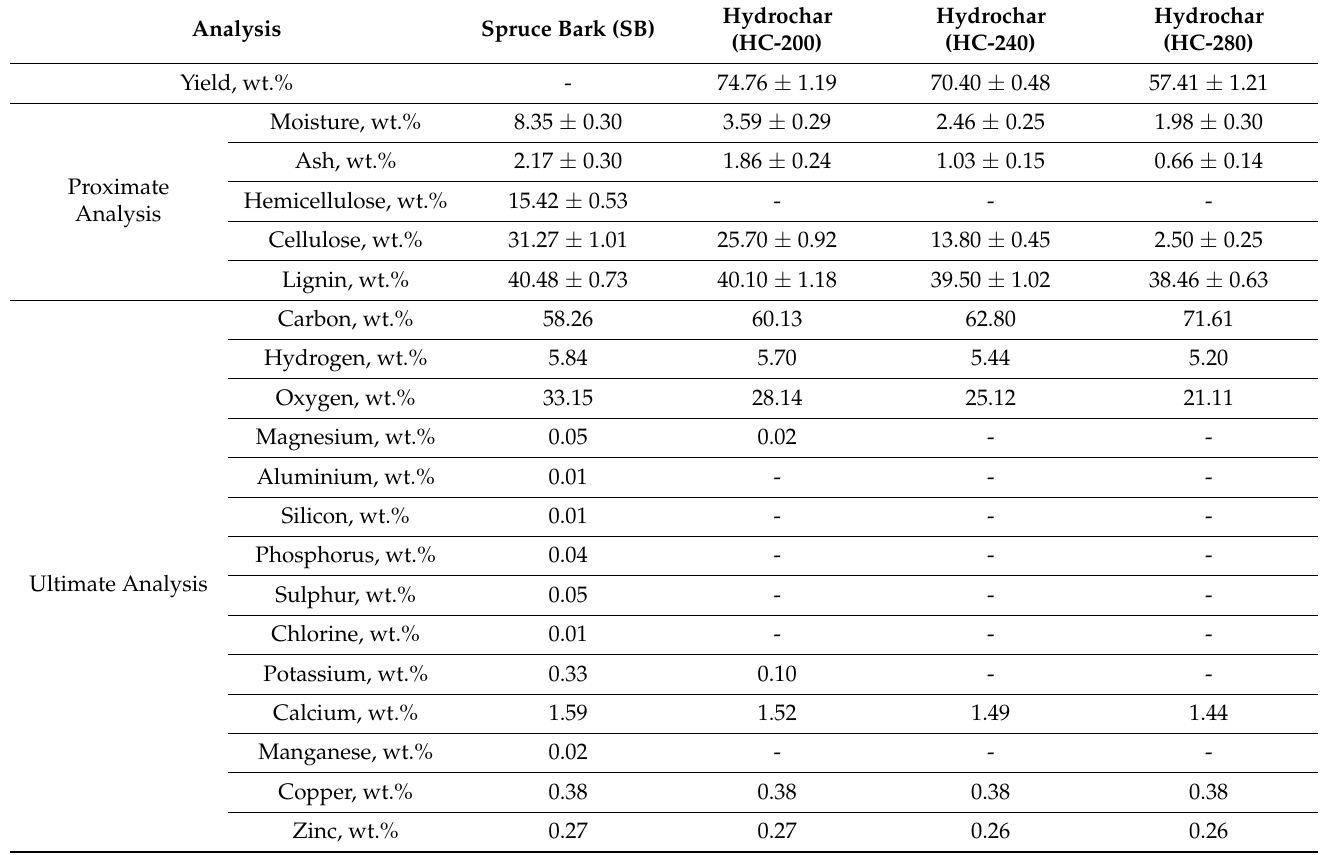
Table 4. Main physical and chemical characteristics of spruce bark and